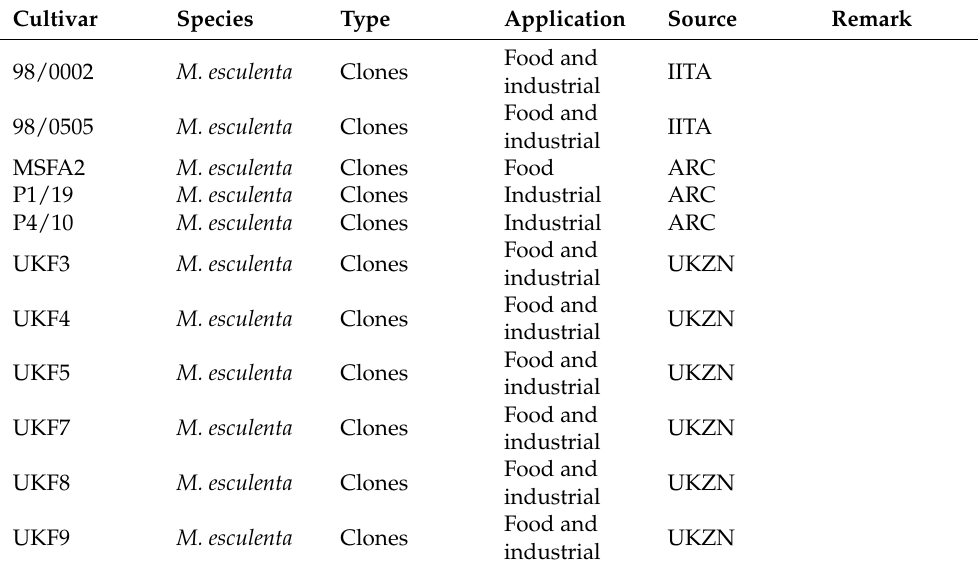
Table 6. Descriptions of cassava genotypes tested at six different